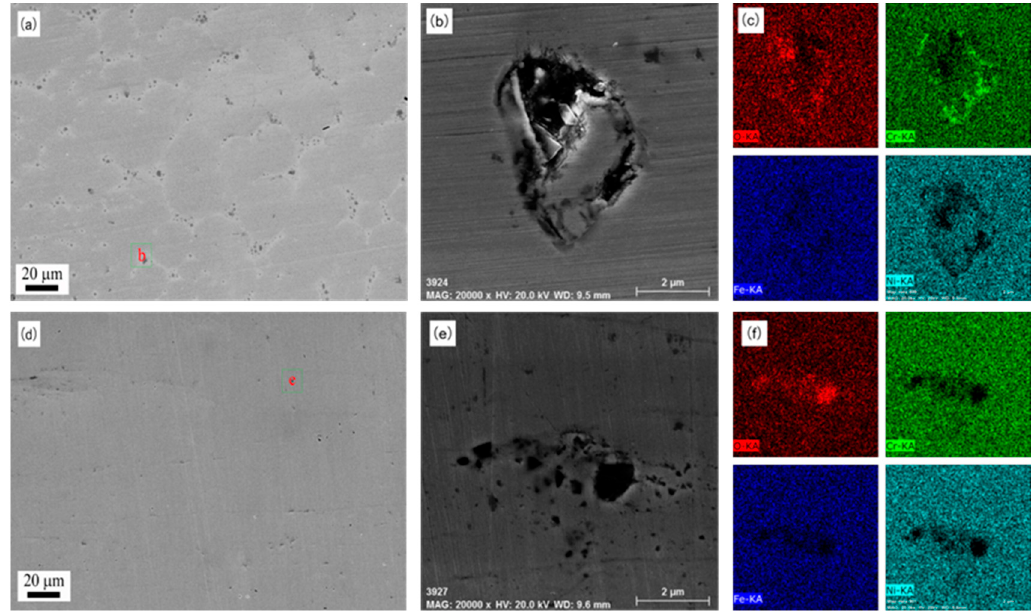
Figure 7. The SEM of alloy 690 ( a ) before and ( d ) after USRT with immersion in the secondary side environment for 1000 h; ( b,e ) the magnified figures and ( c,f ) corresponding surface mapping in ( a,d ), respectively.